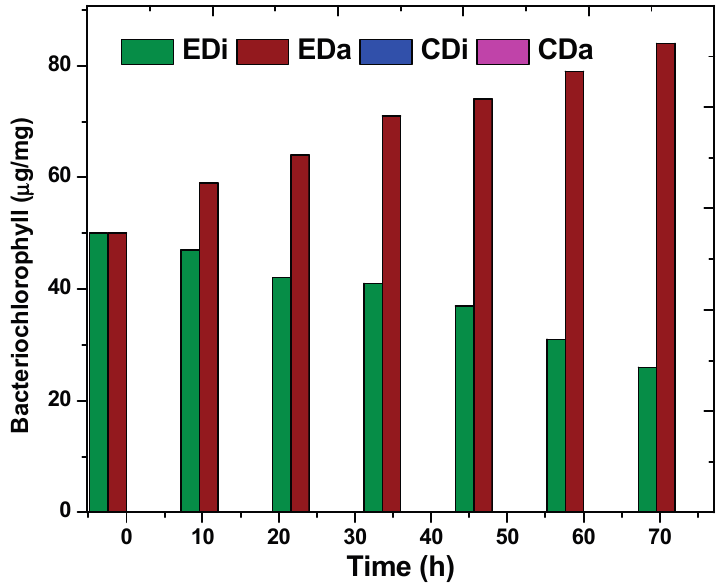
Figure 2. Pigment analysis (bacteriochlorophyll) of dark-fermentative system (DFS-CDi, CDa) and augmented dark-photo fermentative system (ADPFS-EDi, EDa) as function of time with distillery and dairy wastewater.